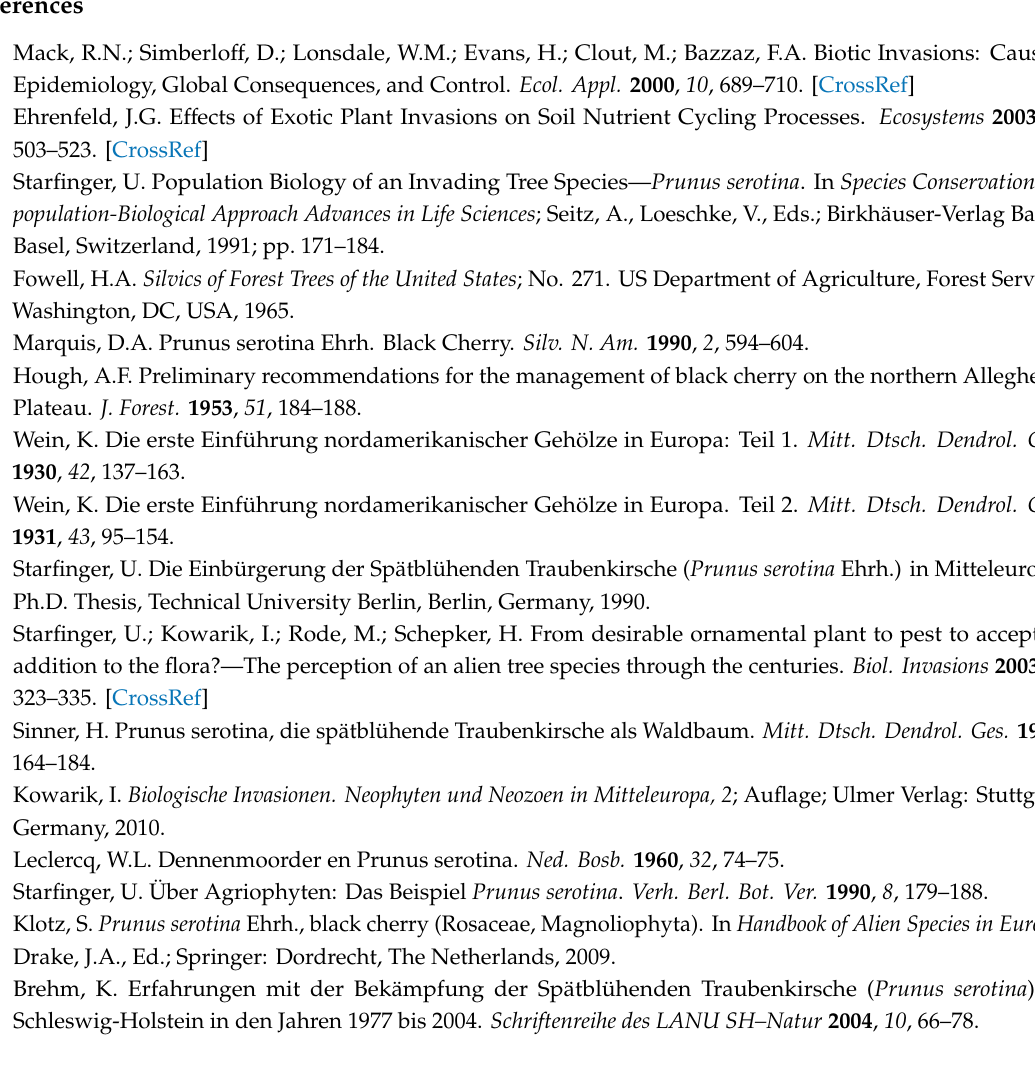
Table S1: Seedling mortality, Table S2: Seedling data, Table S3: Abbreviations, Figures